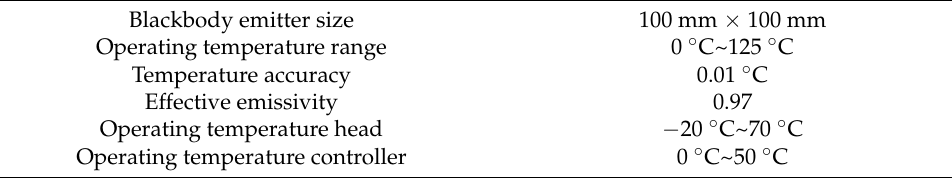
Table 2. Parameters of the area source